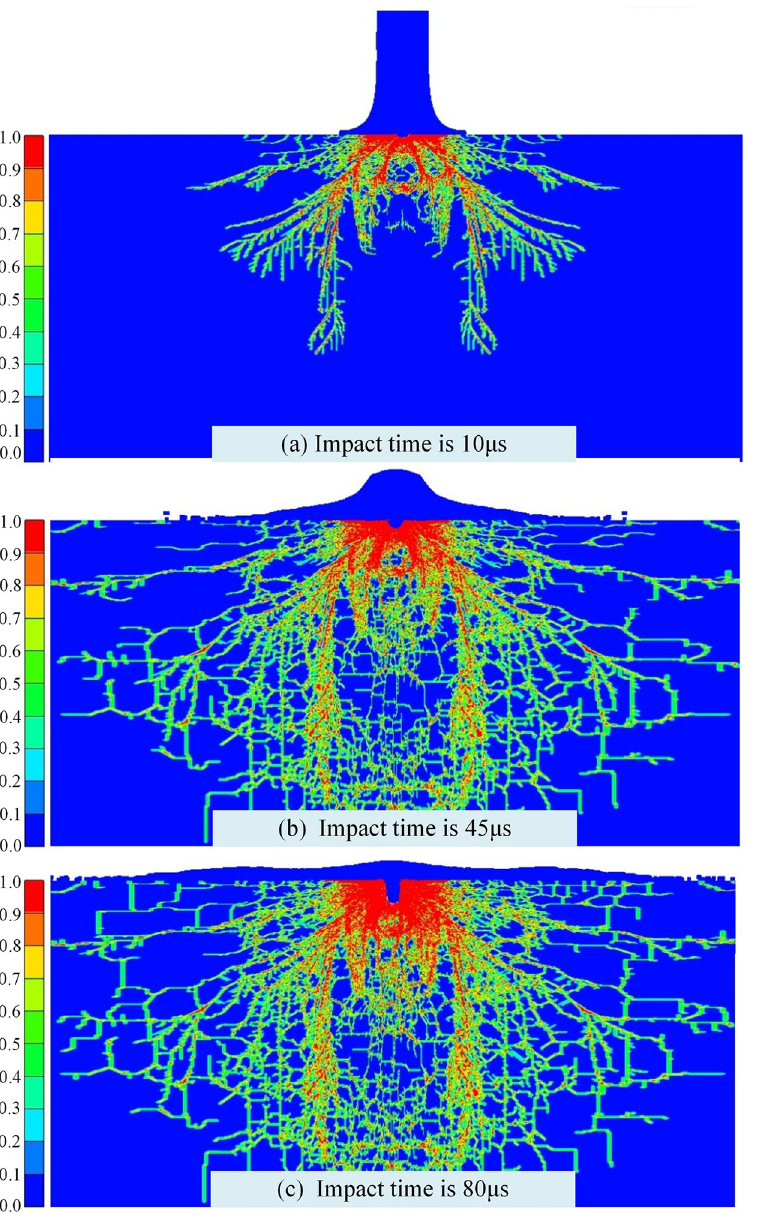
Fig 7. Damage evolution and broken effect of particle jet coupled impact